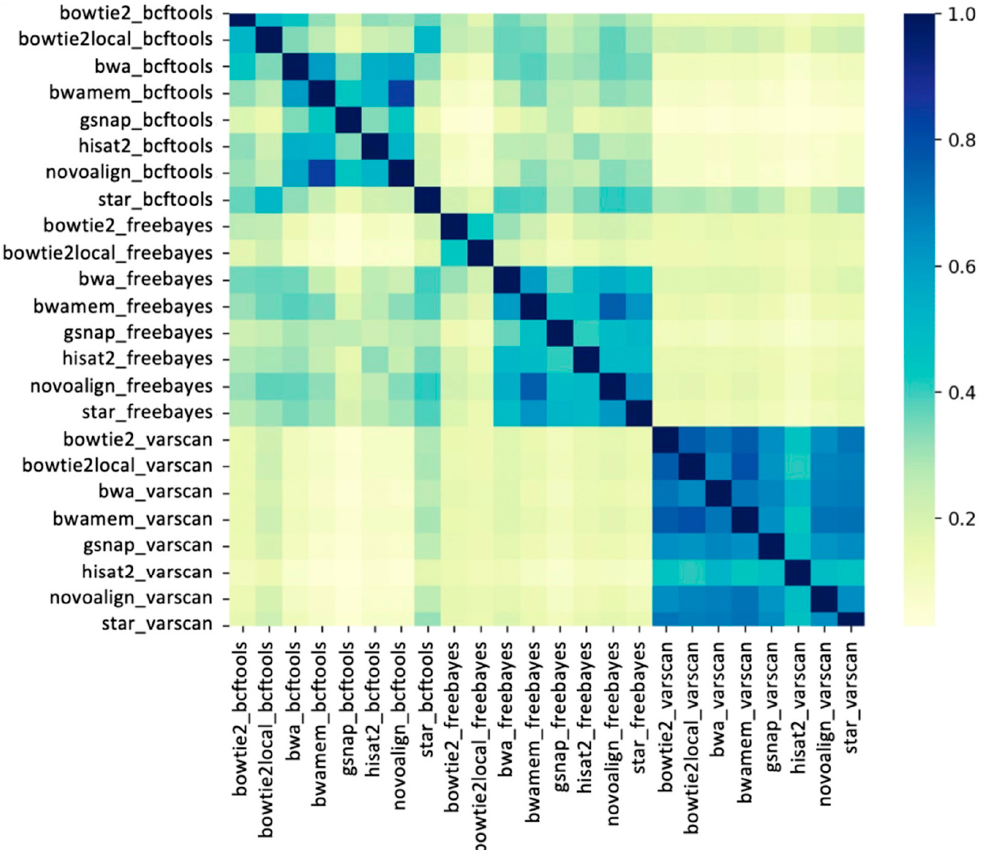
Figure 4. Heatmap showing the similarity between pipelines. The Jaccard indexes between pairs of pipelines were calculated for each sample and averaged across all 48 wheat samples. Color bar shows the Jaccard indexes between 0 and 1, where 1 indicates the identical pipelines.